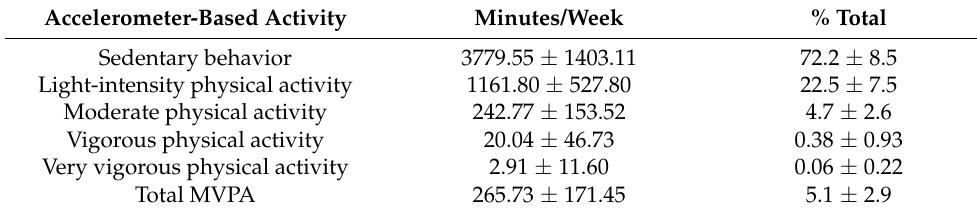
Table 2. Accelerometer-based physical activity level ( n =